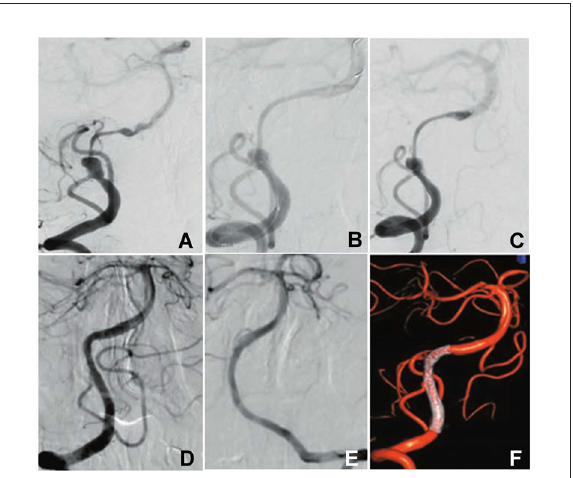
TABLE 2 Endovascular treatment and follow-up.